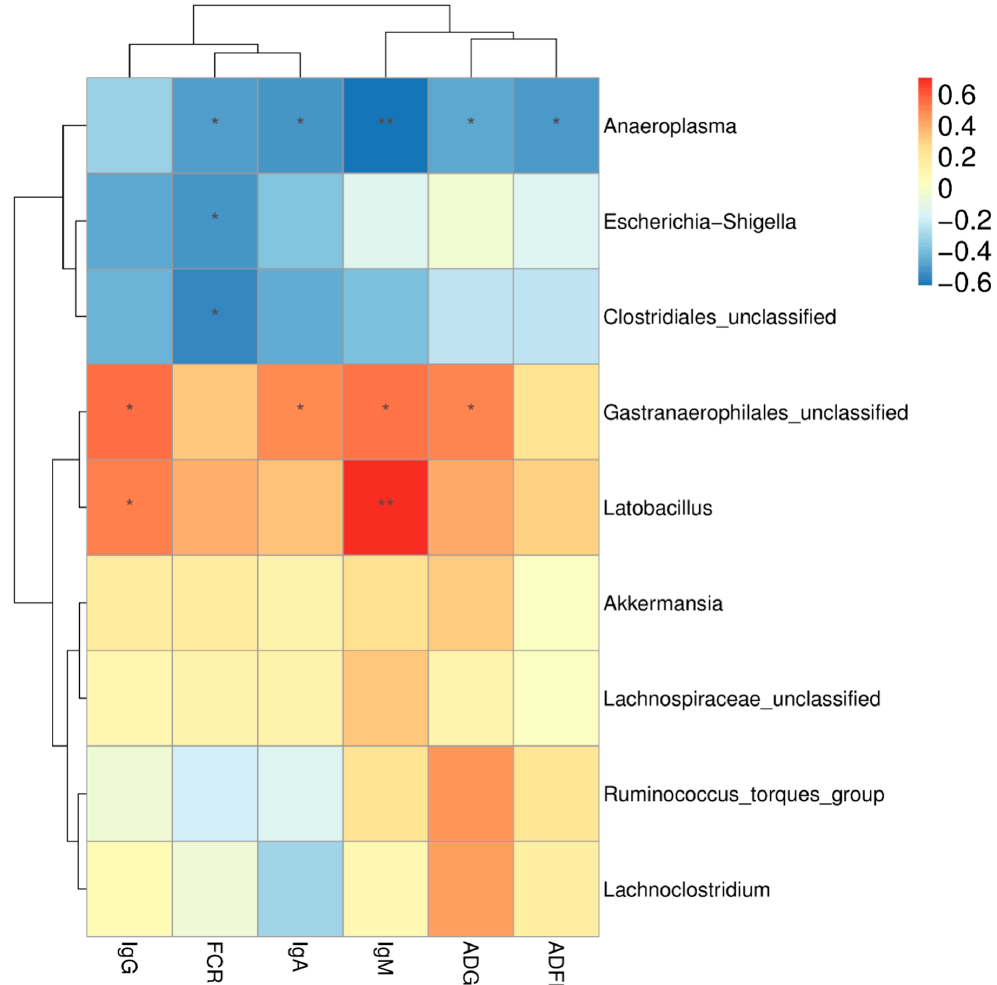
Figure 5. Spearman’s rank correlation analysis between significantly modified microbiota and growth performance and serum immunoglobulin concentrations of broilers. * p < 0.05, ** p < 0.01. Red represents a positive correlation, and blue represents a negative correlation. ADFI, average daily feed intake; ADG, average daily gain; FCR, feed conversion ratio; IgA, immunoglobulin A; IgM, immunoglobulin M; IgG, immunoglobulin G.